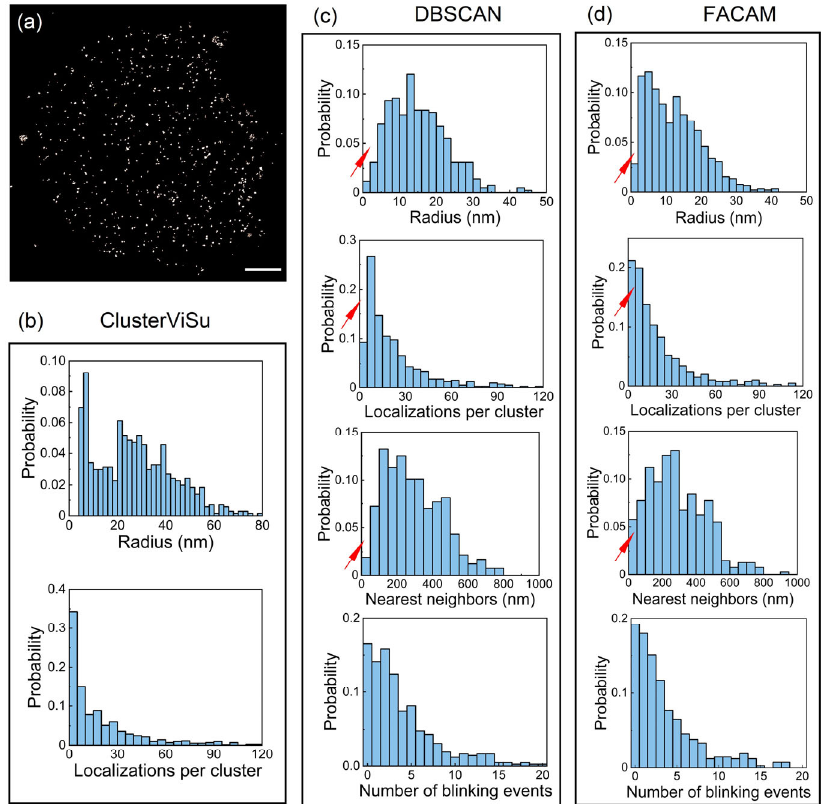
Figure 6. Quantitative analysis on the clustering results from FACAM. ( a ) A reconstructed super- resolution image of the distribution of CD138 on a RPMI-8226 cell. Scale bar: 2µm. ( b ) The results of ClusterViSu in ( a ). Here we obtained 703 clusters. ( c ) The results of DBSCAN in ( a ). Here we obtained 418 clusters. ( d ) The results of FACAM in ( a ). Here we obtained 423 clusters. The red arrows point out main di ff erences in the distribution of results between DBSCAN and FACAM.